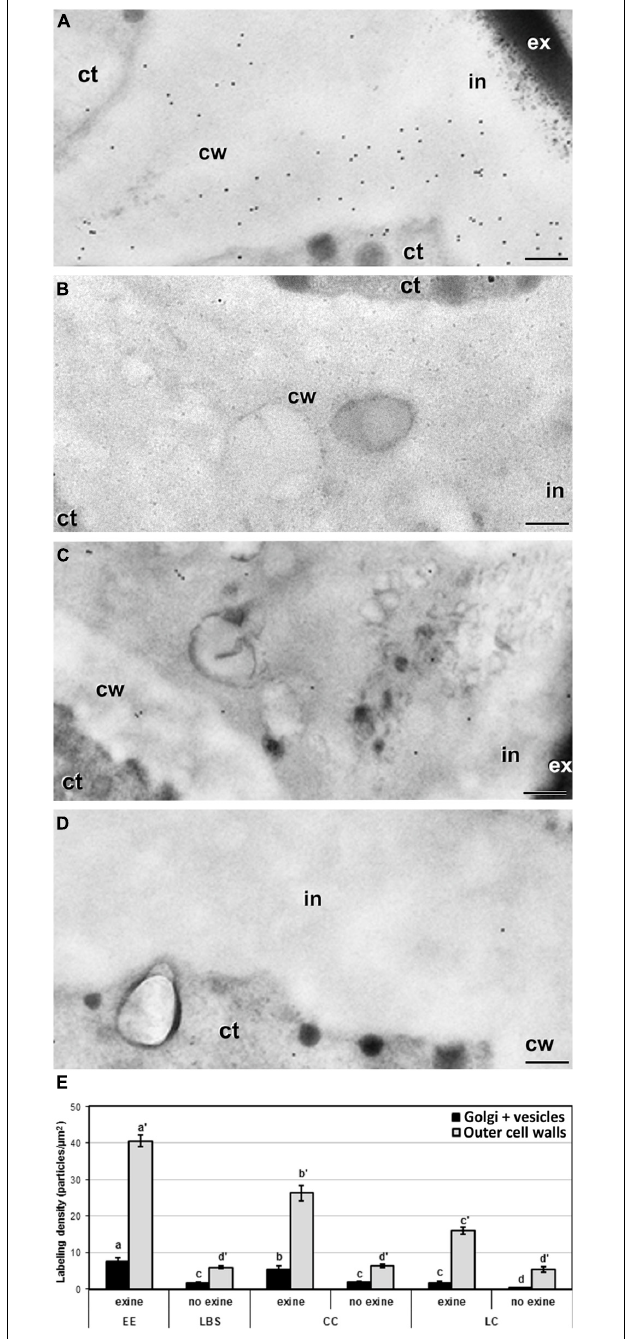
FIGURE 8 | Detection of JIM7 cross-reacting highly methyl-esterified by immunogold labeling and quantification in TEM images of cell wall regions connecting to outer walls from 5-day-old microspore cultures. Images of cell wall regions connecting with outer walls in EE (A) , LBS without exine (B) , and LC with (C) and without exine (D) . (E) Quantification of JIM7-cross-reacting highly methyl-esterified pectin in cytoplasmic Golgi stacks and vesicles and outer cell wall in different types of structures and in areas with or without exine. Labeling density is expressed in number of particles per µ m 2 . Different letters represent statistically significant differences obtained with LSD test. ct, cytoplasm; cw, cell wall; ex, exine; in, intine. Bars: 200